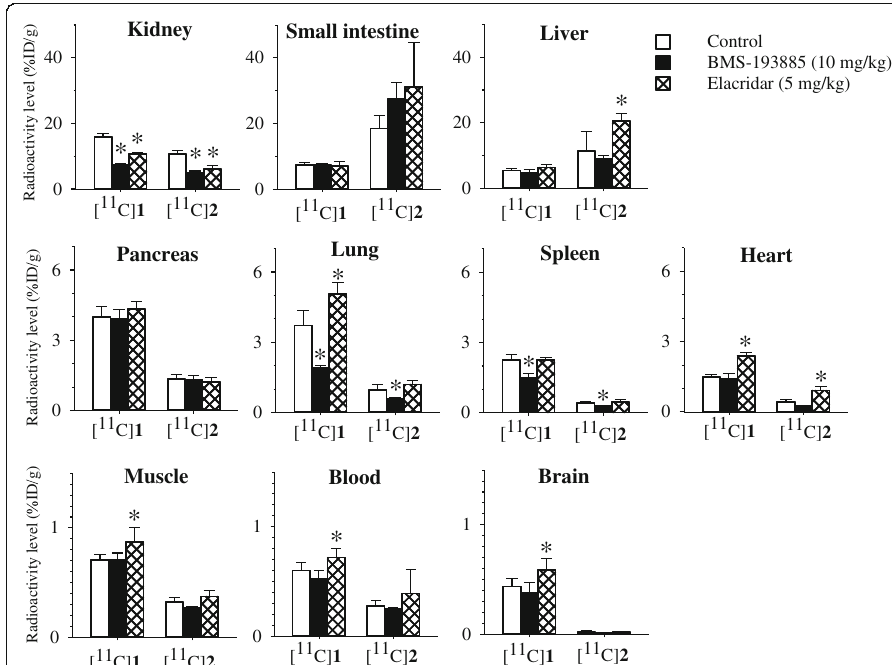
Fig. 2 The effects of pretreatment with 1 (10 mg/kg) or elacridar (5 mg/kg) on the biodistribution of radioactivity at 30 min post-injection with [ 11 C] 1 or [ 11 C] 2 in mice. The injected dose of [ 11 C] 1 or [ 11 C] 2 were 7.1 – 14 MBq (0.079 – 0.23 nmol) or 6.0 MBq (0.16 nmol), respectively. The radioactivity level was expressed as the mean